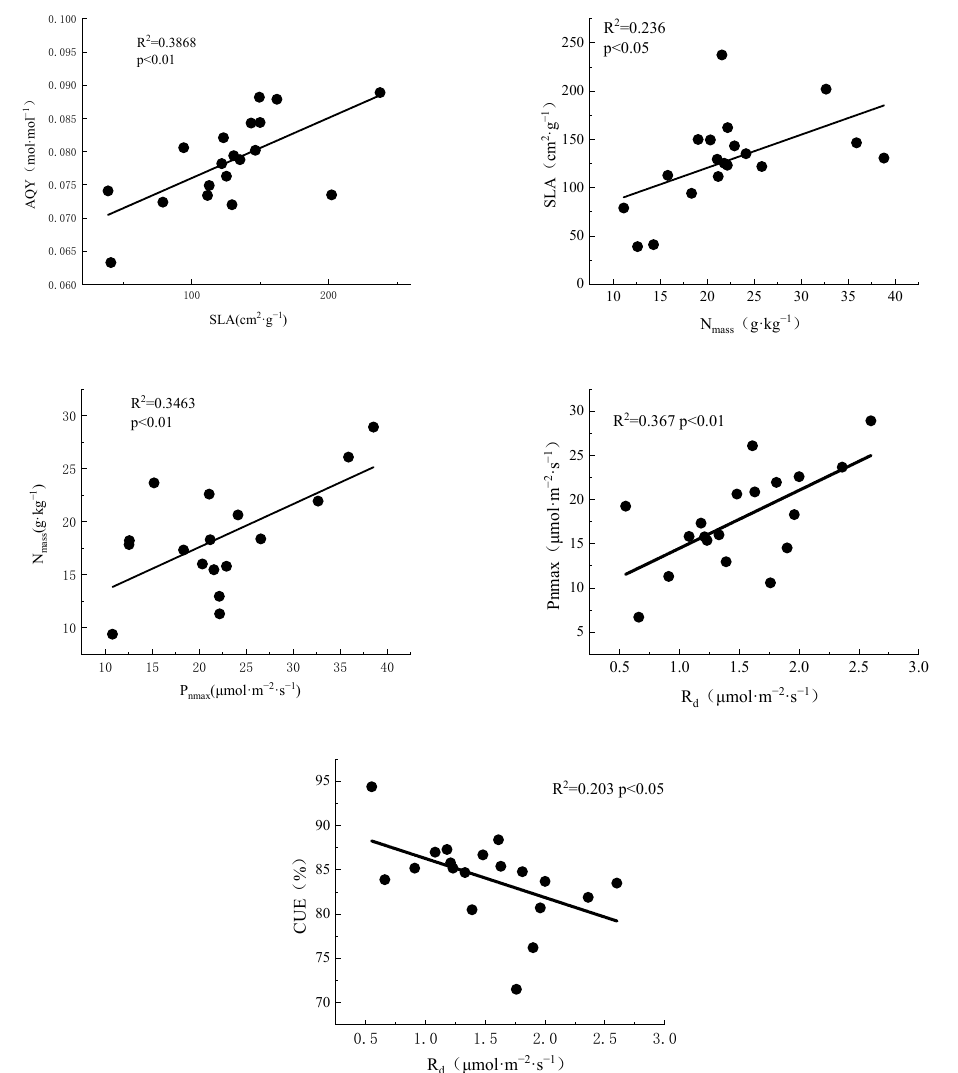
Figure 6. Relationship between specific leaf area (SLA) and apparent quantum yield (AQY), leaf nitrogen content (N mass ) of different species. Relationship between leaf nitrogen content (N mass ) and maximum net photosynthetic rate (P nmax ) of different species. Relationship between dark respiratory rate (R d ) and maximum net photosynthetic rate (P nmax ), carbon use efficiency (CUE) of different spe- cies.